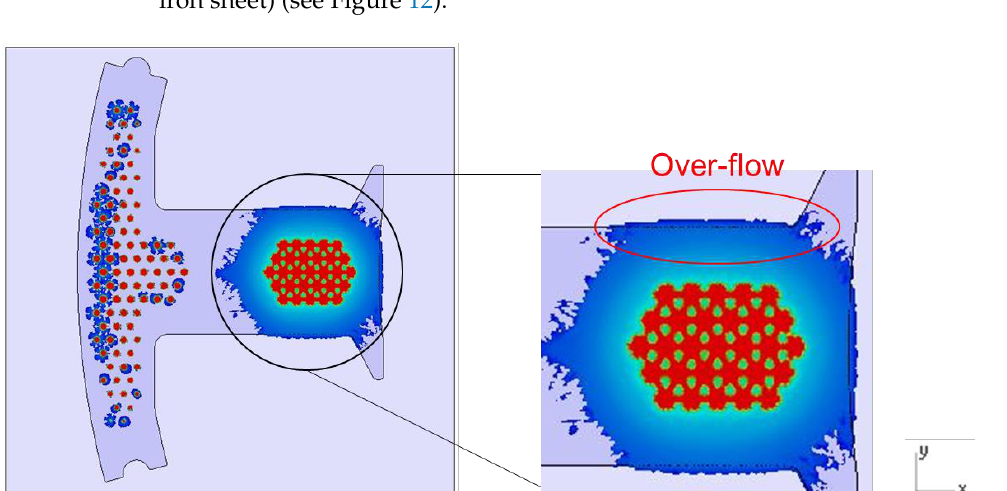
Figure 11. Top view of the dipping process results.